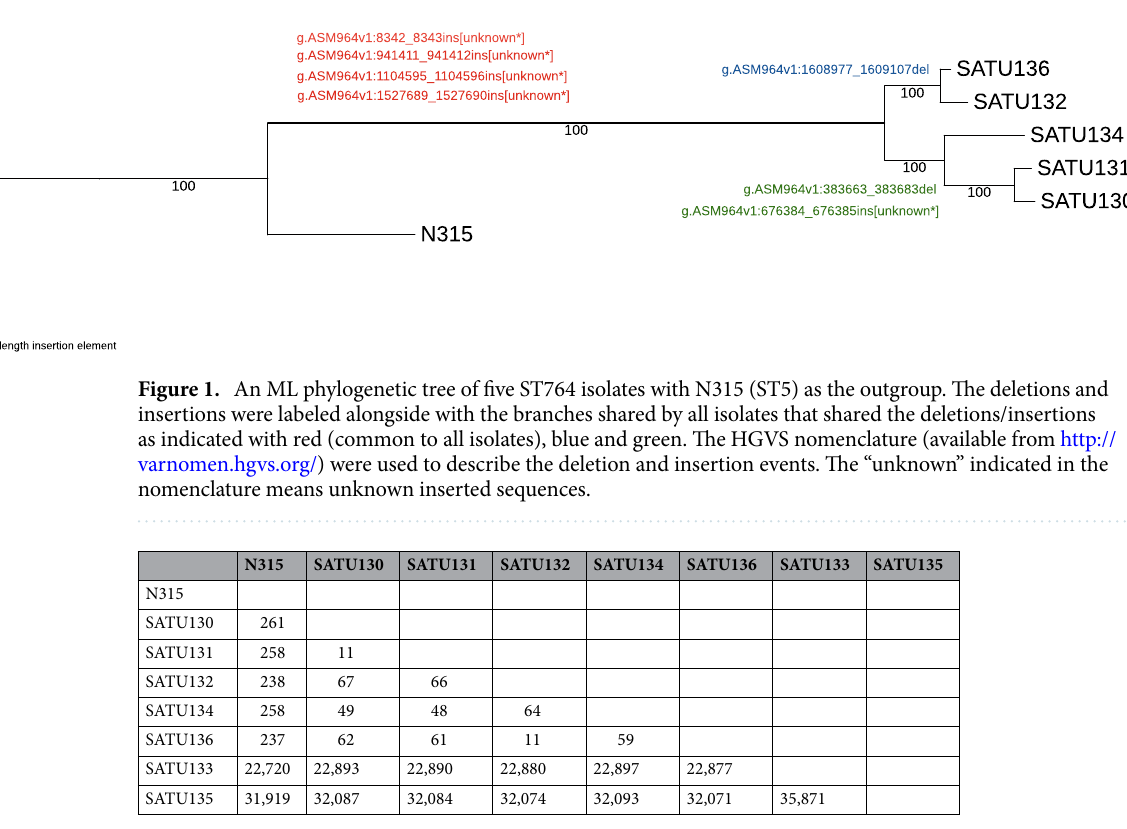
Table 3. Number of SNV differences between each pair of